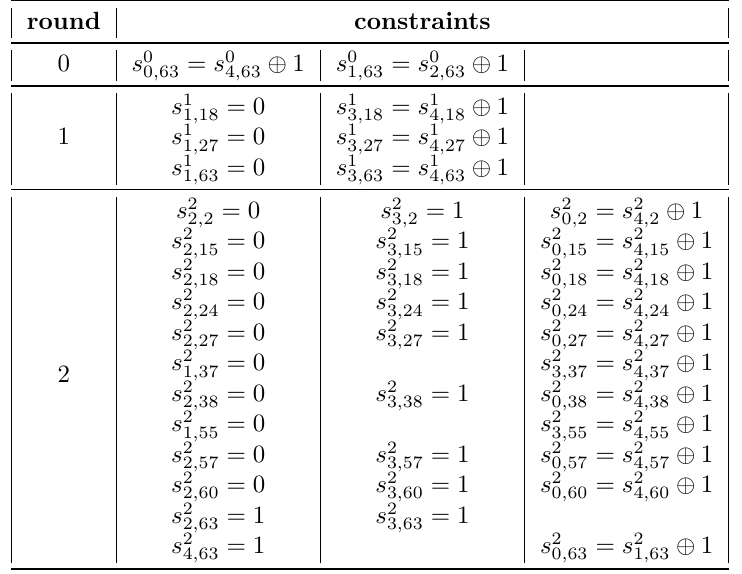
Table 10: Constraints generated by active Sboxes of